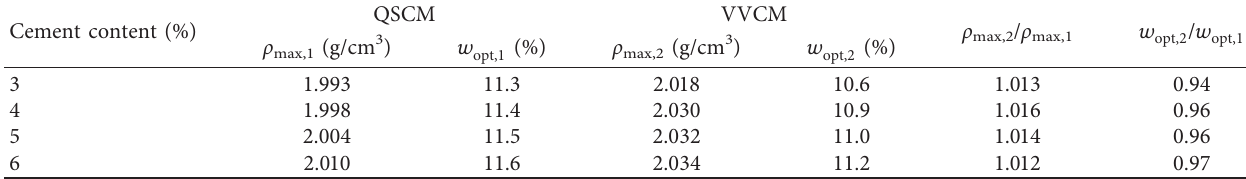
Table 5: Maximum dry density and optimum water content of the CSL.